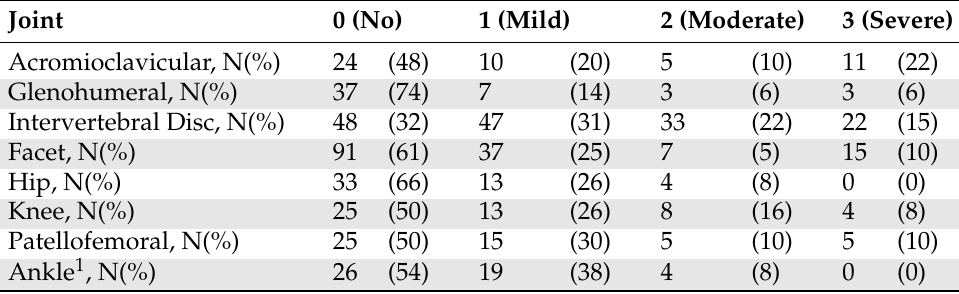
Table 2. Frequency of grades per joint ( n = 25